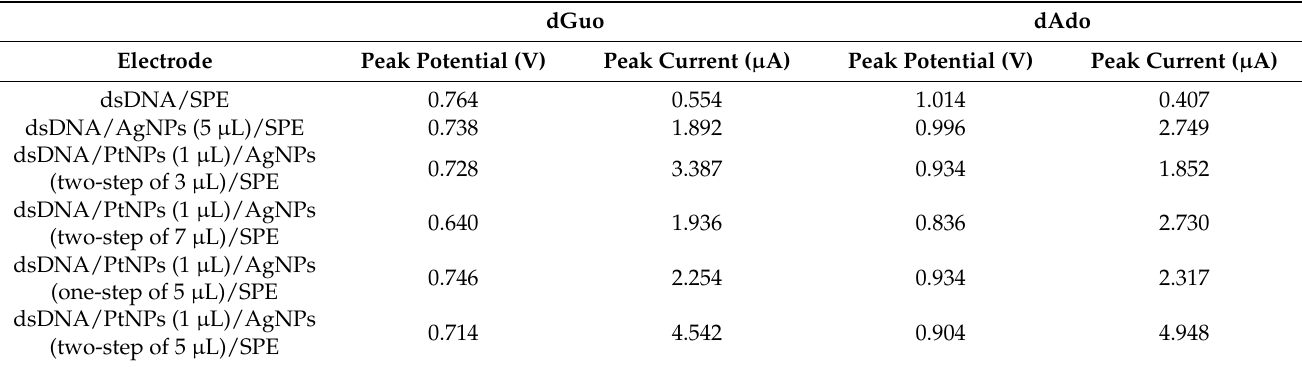
Table 2. The comparison of dGuo and dAdo signals in pH 4.70 AB by DPV at various AgNPs volume of modified electrodes. dGuo